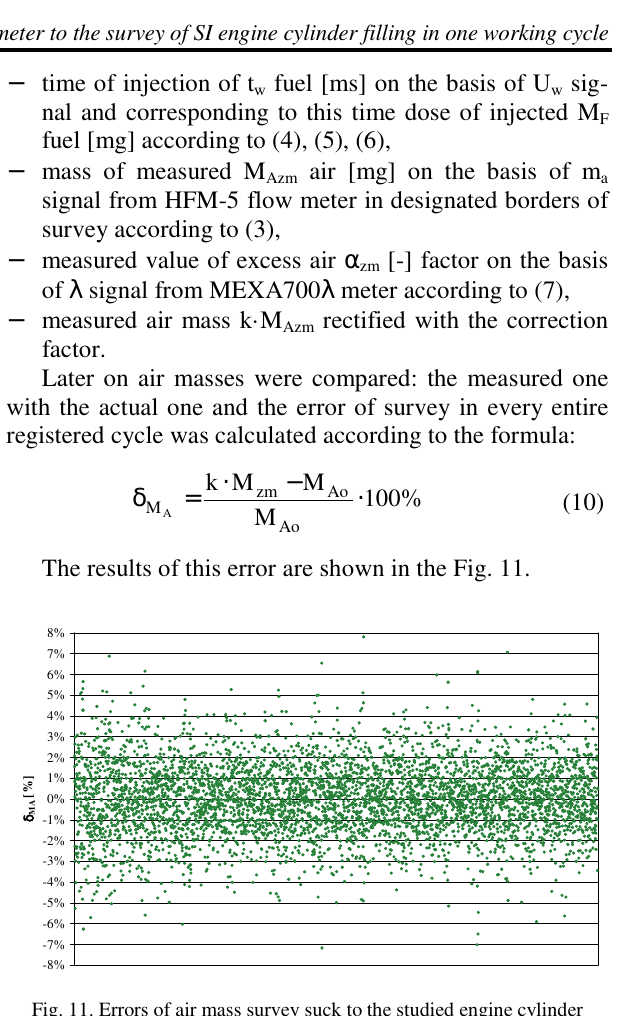
Fig. 11. Errors of air mass survey suck to the studied engine cylinder